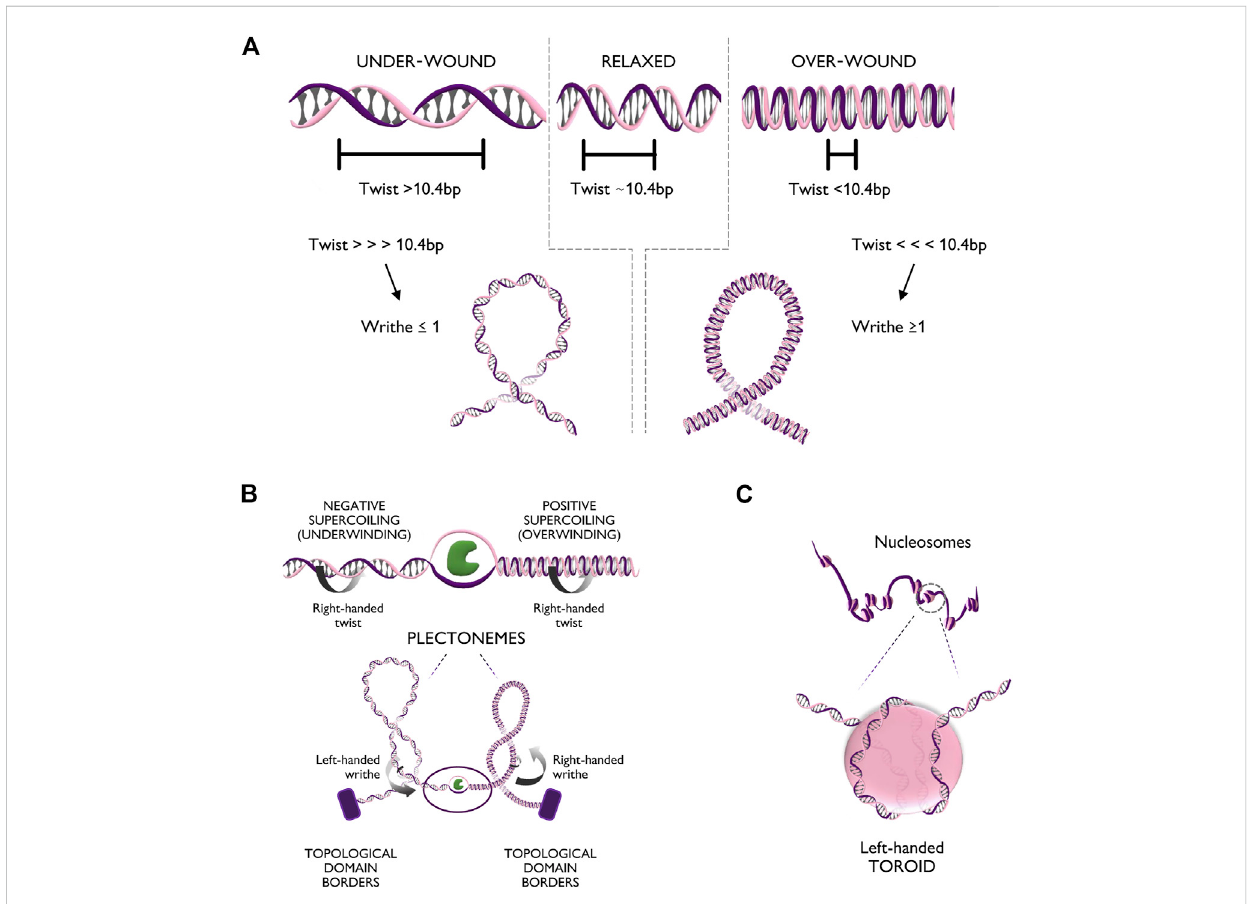
FIGURE 2 Torsional stress deforms the DNA fi ber in multiple con fi gurations. (A) Top panel: Different levels of twist of the DNA helix, respectively relaxed (bps per turn ~10.4), under-wound (bps per turn > 10.4), and over-wound (bps per turn < 10.4). Bottom panel: Extreme twist levels result in further conformational changes in which the helix bends on itself generating positive writhe (right handedness) or negative writhe (left handedness). (B) Top panel: Unwinding of the DNA double helix creates positive supercoiling (over-winding) ahead of the unwinding factor (in green) and negative supercoiling (under-winding) behind. Bottom panel: Supercoiling can generate additional tridimensional rearrangements of the chromatin fi ber such as plectonemes with positive or negative writhe. (C) Zoom-inof theDNAcon fi guration ofa nucleosome unit. The helix, characterized by right handedness, wraps around the nucleosome core particle in the form of a left handed spiral